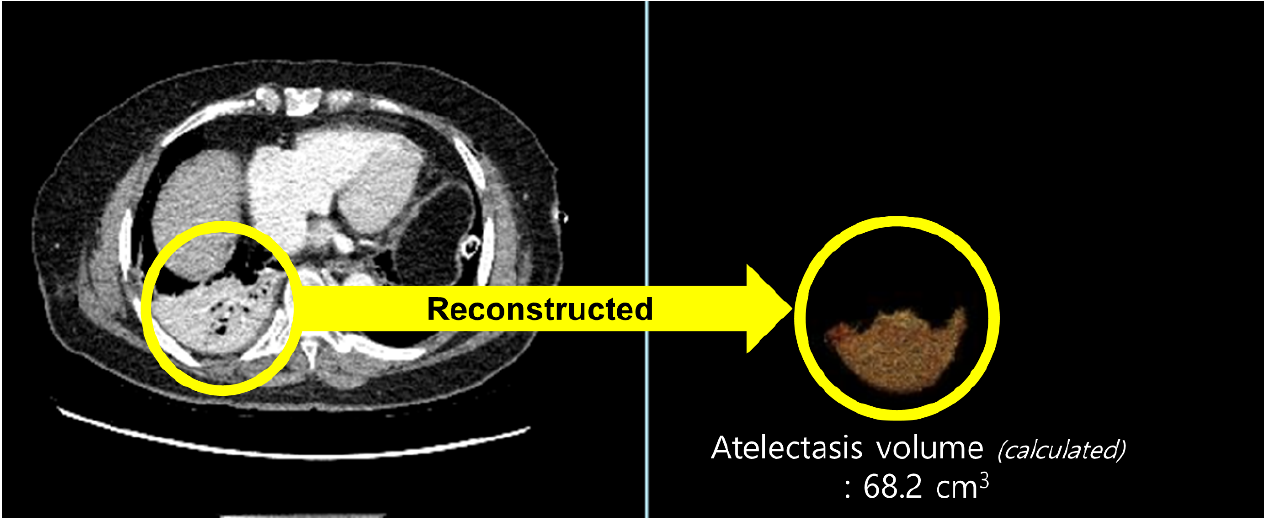
Figure 1. Quantitatively measured volume of an atelectatic lung using threshold methods in chest computed tomography. For the calculation of atelectatic lung volume, the area with predefined Hounsfield unit (HU) threshold of − 100 to 100 HU was selected in the chest computed tomography images (yellow circle on the left) and reconstructed (yellow circle on the right).